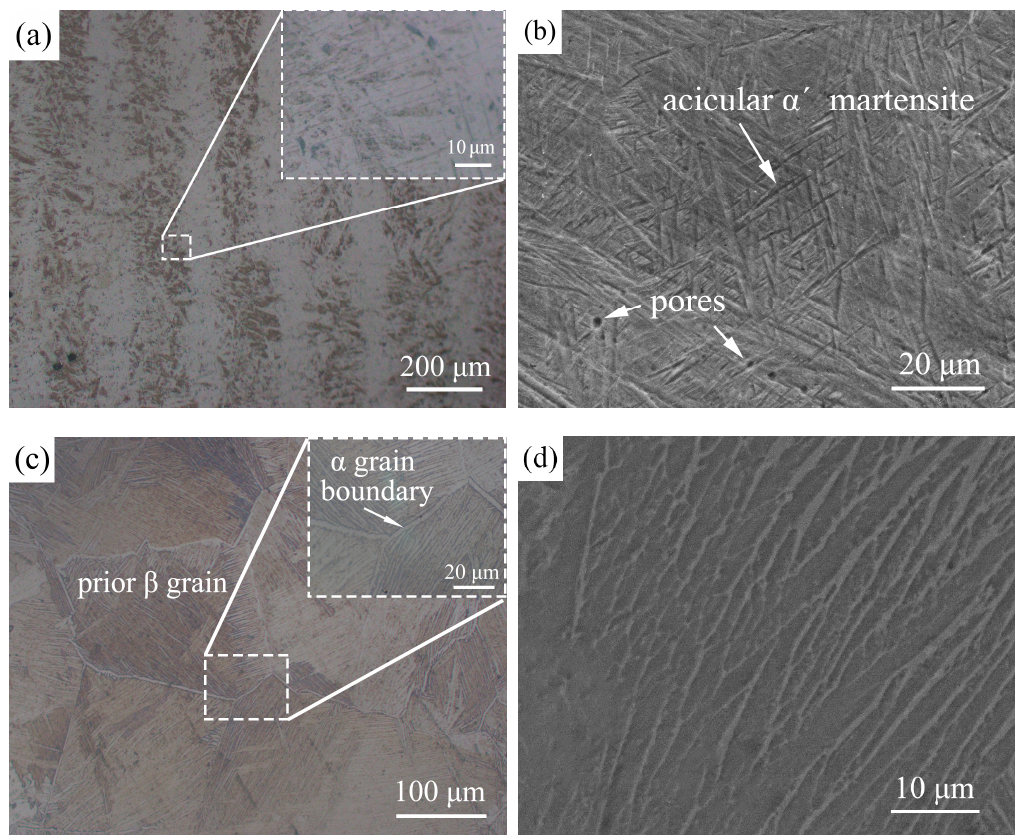
Figure 6. Microstructure of the SLMed TC4: ( a ) OM image and ( b ) SEM image before wetting; ( c ) OM image and ( d ) SEM image after wetting.